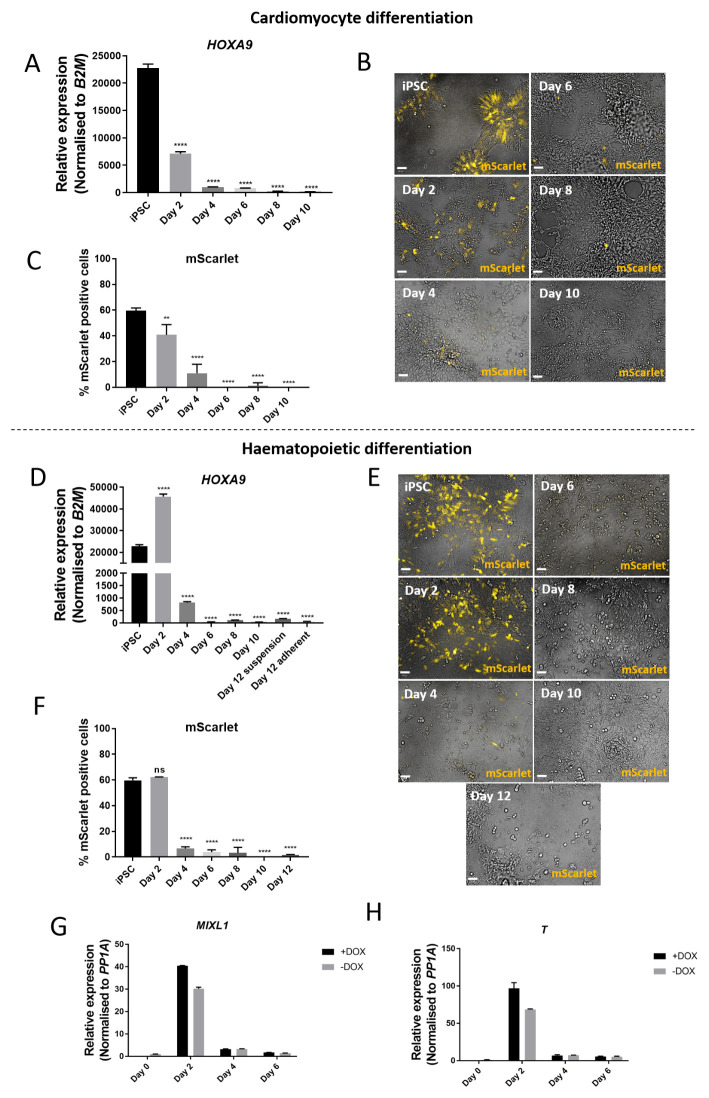
Differentiation towards cardiomyocytes or haematopoietic cells results in silencing of
AAVS1-targeted transgene after mesoderm induction.(
A) qRT-PCR performed on hiPSCs targeted at the
AAVS1 locus with a doxycycline-inducible HOXA9-T2A-mScarlet construct undergoing cardiomyocyte differentiation. Relative expression to untargeted hiPSCs. Reduced expression of the transgene is observed from day two onwards. (
B) Live imaging of
AAVS1-targeted hiPSCs undergoing cardiomyocyte differentiation at different timepoints. mScarlet expression peaks on day 0 and reduces throughout the differentiation, despite repeated doxycycline treatment. Scale bars = 50 µm. (
C) Quantification of mScarlet expression using high content image analysis at different timepoints during cardiomyocyte differentiation. (
D) qRT-PCR performed on hiPSCs targeted at the
AAVS1 locus with a doxycycline-inducible HOXA9-T2A-mScarlet construct undergoing haematopoietic differentiation. Relative expression to untargeted hiPSCs. Reduced expression of the transgene is observed from day four onwards. (
E) Live imaging of
AAVS1-targeted hiPSCs undergoing haematopoietic differentiation at different timepoints. Scale bars = 50 µm. (
F) Quantification of mScarlet expression using high content image analysis shows peak expression on day two and reduced expression thereafter. Mean ±SD, n = 2 differentiations. One-way ANOVA with Dunnett’s multiple comparison test, ** p = 0.0036; **** p ≤ 0.0001. (
G,
H) The mesoderm markers
MIXL1 and Brachyury (
T) show peak expression at day two of haematopoietic differentiation.